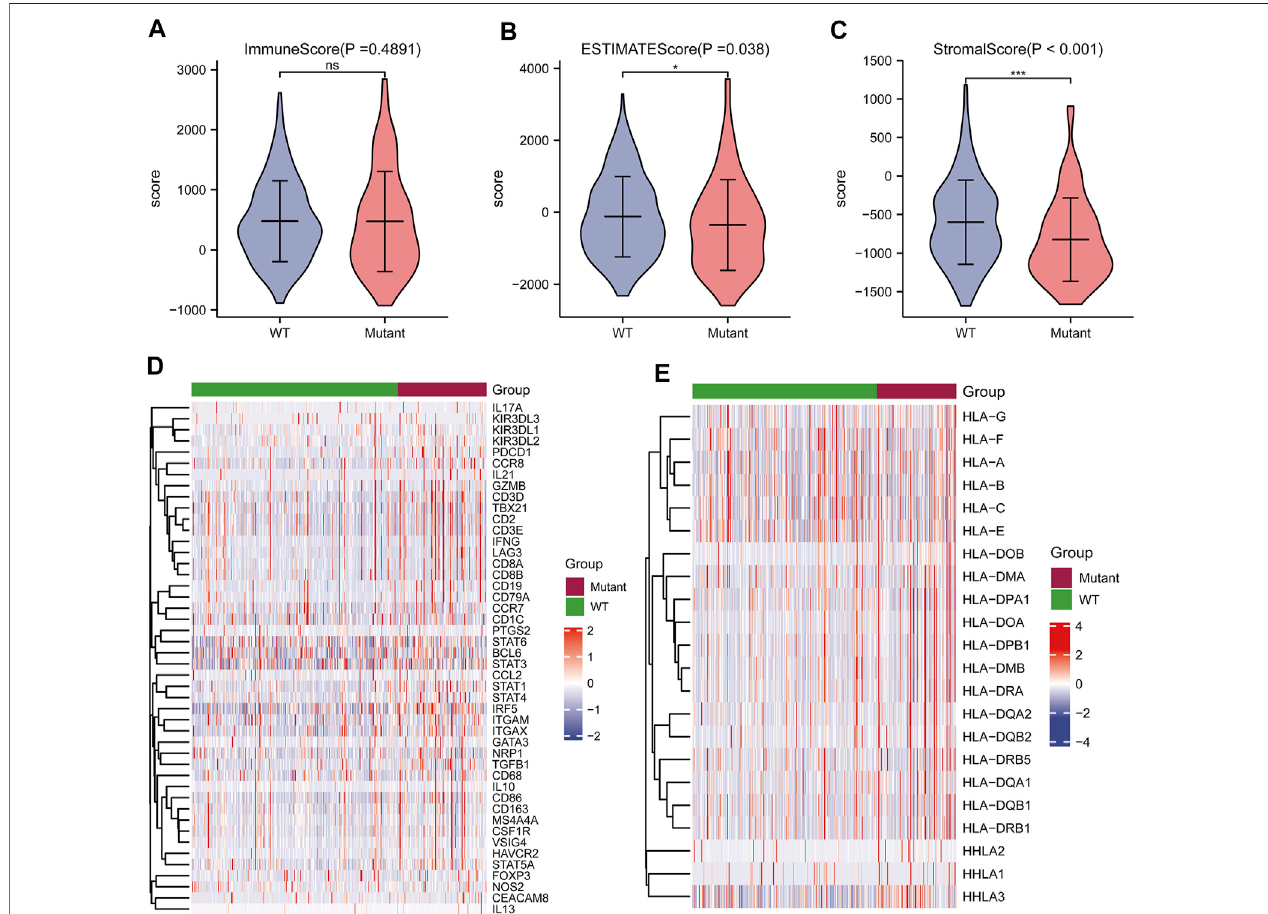
FIGURE7| EffectofTP53mutationontheimmunologicalcharacteristics ofTCGA-LIHCpatients. (A) :ImmuneScorehasnosigni fi cantdifference( p =0.4891). (B) : ESTIMATEScoredecreasedsigni fi cantly( p =0.038). (C) :StromalScorewassigni fi cantlyreduced( p < 0.001). (D) :ClusterheatmapofTP53mutationandimmunegene. (E) : Cluster heat map of TP53 mutation and HLA gene